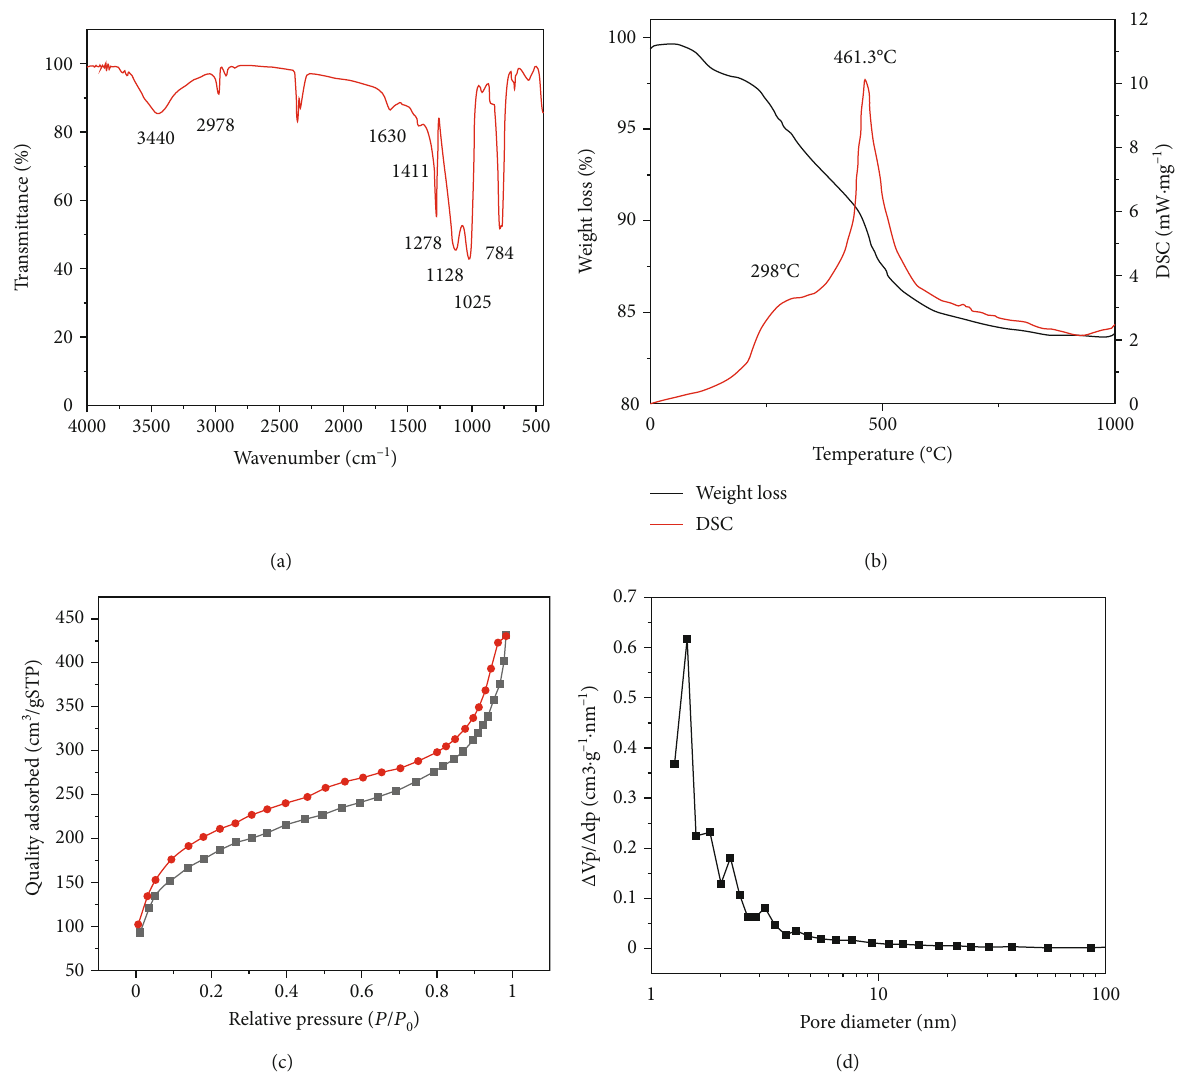
Figure 4: (a) FTIR of silica aerogel based on VTMS, (b) DSC and TG curves of silica aerogel based on VTMS, (c)N isotherm curves of silica aerogel based on VTMS, and (d) pore size distribution of silica aerogel based on